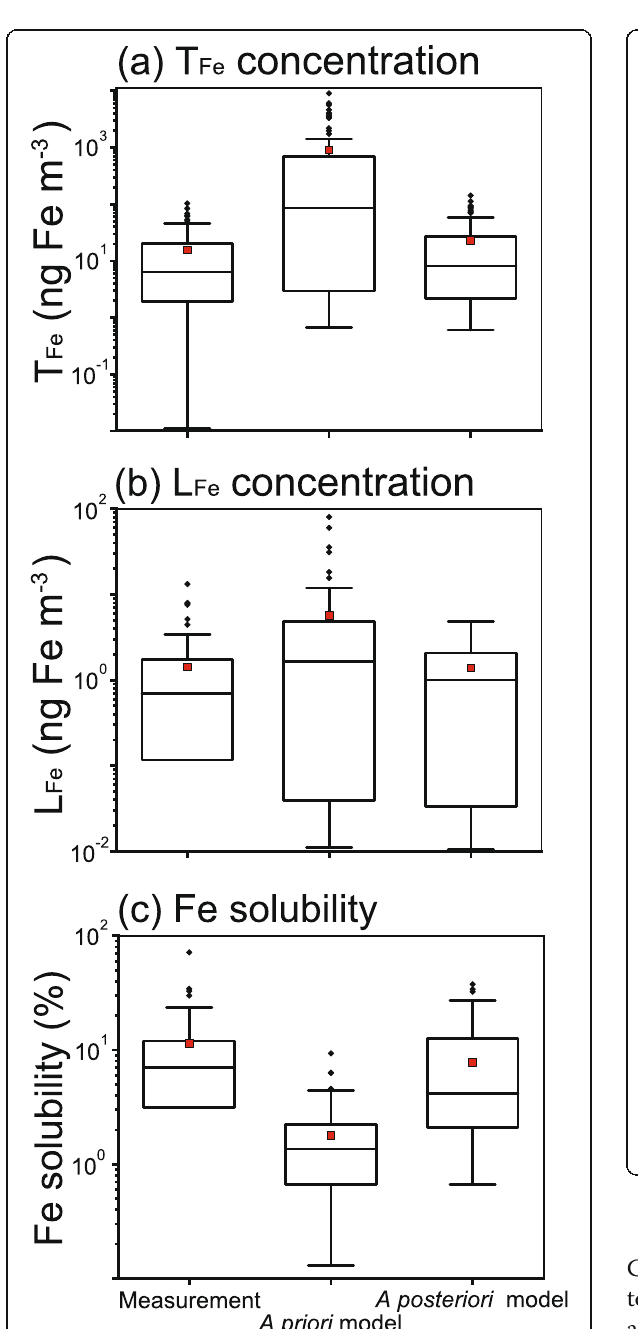
Fig. 4 Concentrations of a T Fe and b L Fe concentrations (ng Fe m – 3 ), and c Fe solubility (%) for observations, a priori model estimates, and a posteriori model estimates over the 70°E – 150°E and 10°S – 70°S oceanic sector of the SH. The red square symbol represents the mean. The solid line within the box mark shows the median. The boundaries of the box mark the 25th and 75th percentiles. The whiskers above and below the box indicate the 1.5 × interquartile range, and the points indicate the outside of the range